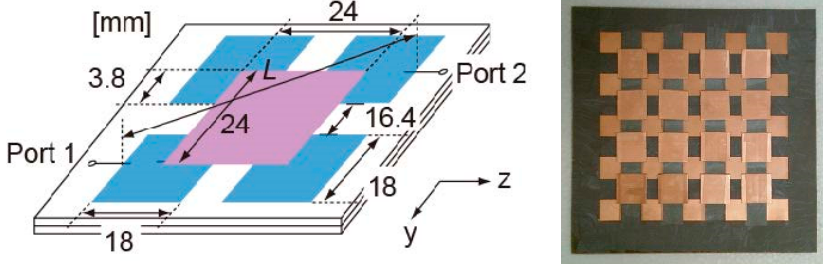
Figure 3. Sheet-like two-dimensional transmission line.